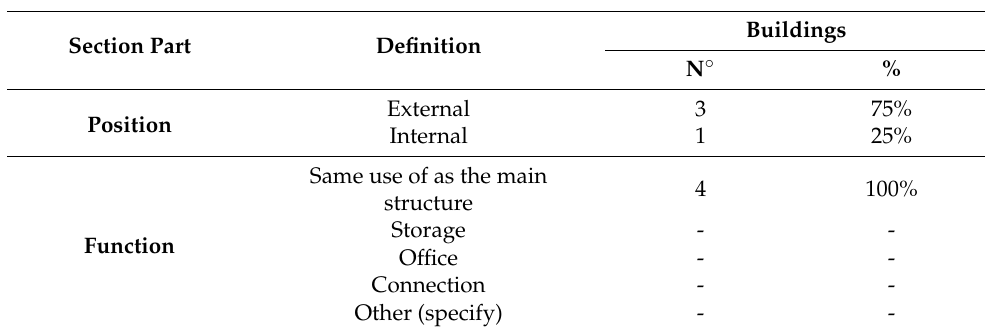
Table 11. Section 2B CARTIS-Building. Case studies characterization: Presence of blocks added to the main structure—Synoptic panel.